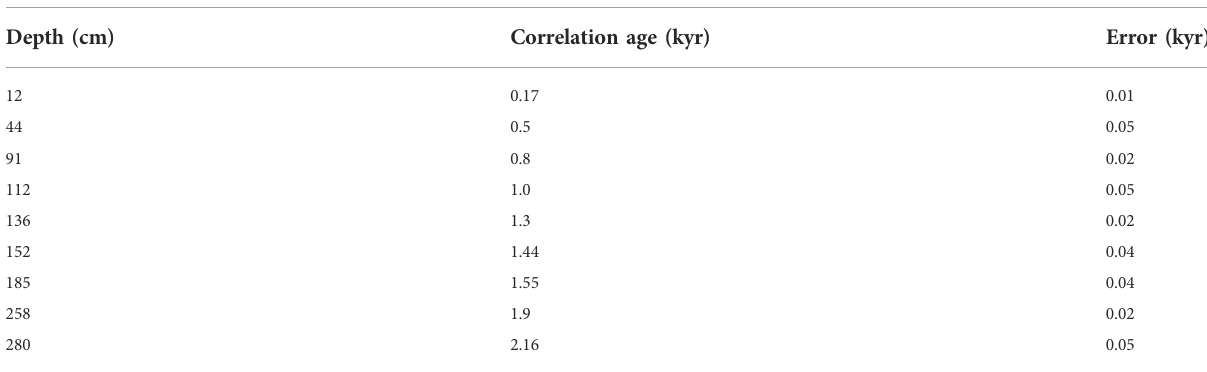
(Supplementary Figure S2B). The T- P projection of magnetic fabric indicates that most specimens had oblate shapes, whereas a few prolate samples had small p values ( < 1.04) (Tarling &